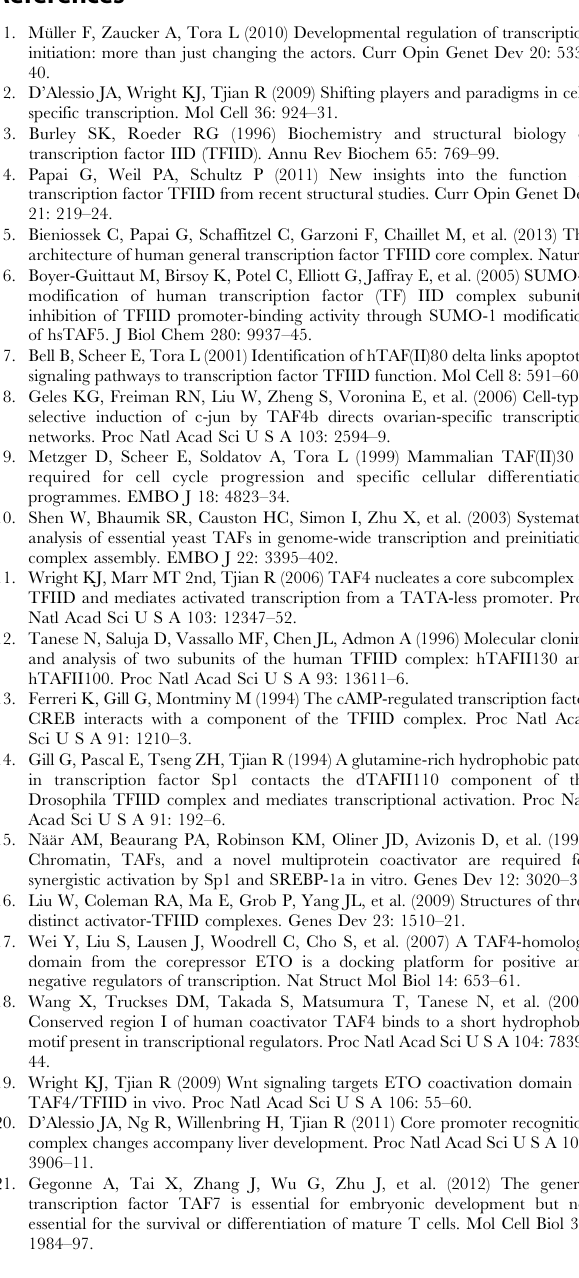
Table S2 List of primers used in the